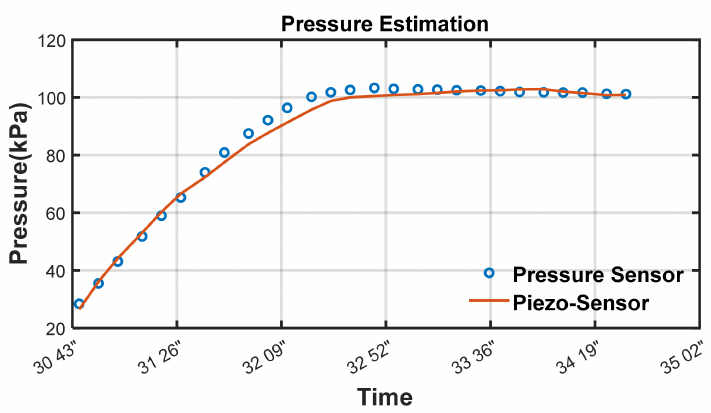
Figure 13. Result of pressure estimation using EMI in the damaged case (test